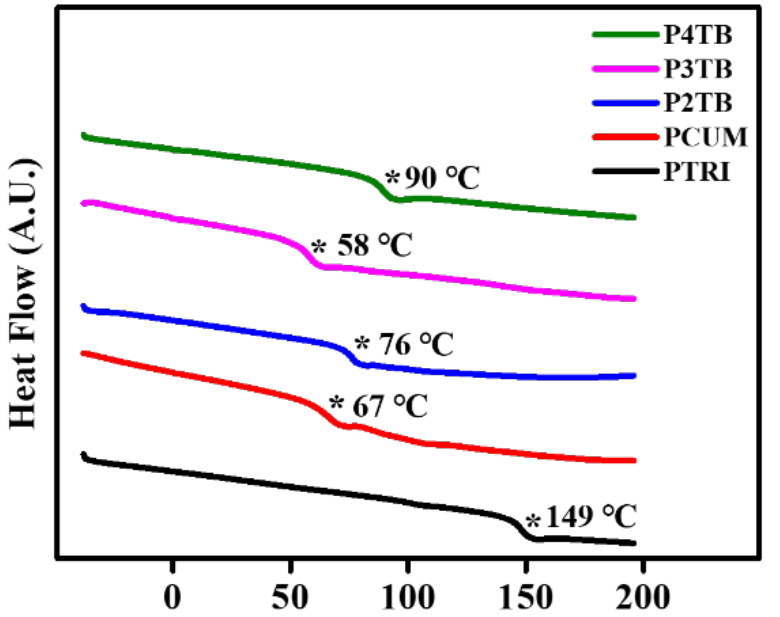
Figure 3. Differential scanning calorimetry (DSC) thermograms of PTRI, PCUM, P2TB, P3TB, and P4TB (* indicates the glass transition).